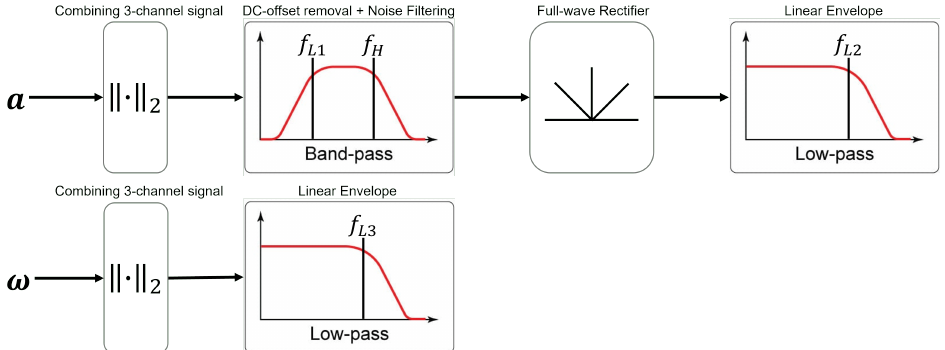
Figure 11. Accelerometer and gyroscope signal processing.